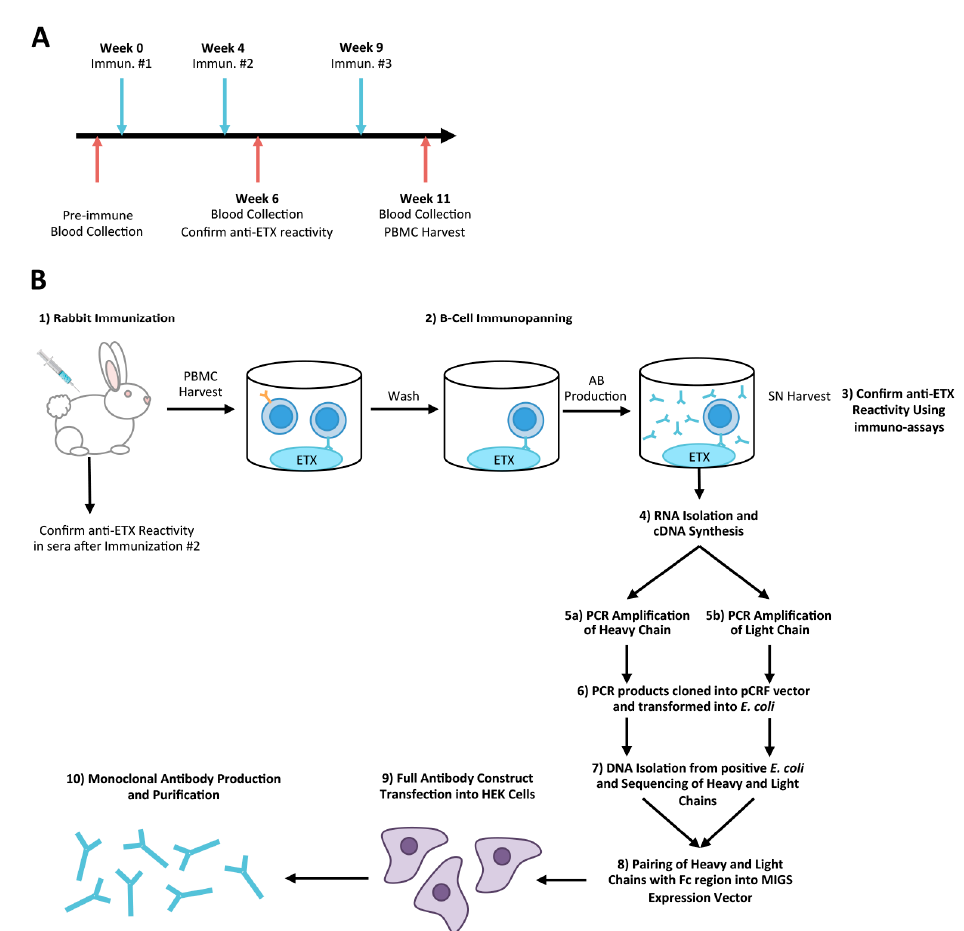
Figure 1. Overview of Rabbit immunization and production of anti-ETX monoclonal antibodies. ( A ) Timeline for rabbit immunization with pETX and blood collection. ( B ) Overview of rabbit B-cell isolation and cloning procedure for production of anti-ETX monoclonal antibodies. For detailed information, please referee to the methods section.